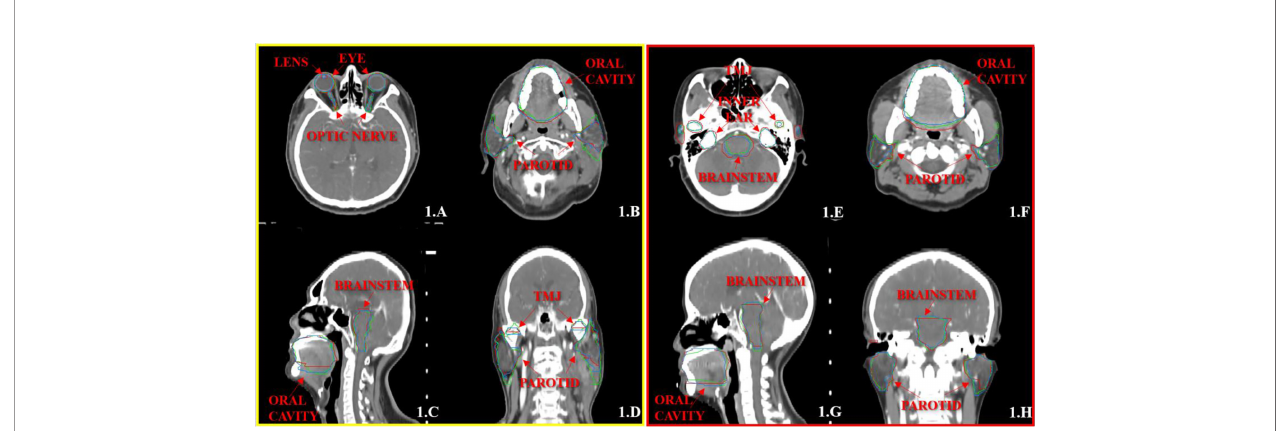
FIGURE 1 | The segmentation results on the atlas and trained DL-based models for two representative cases with the transverse (A, B, E, F) , sagittal (C, G) , and coronal (D, H) images, respectively. The ground-truth delineations are depicted in red, the automatic delineations based on the atlas model are depicted in green, and the automatic delineations based on the trained DL model are depicted in blue. Case 1 is shown in (A – D) , and case 2 is shown in (E – H) .